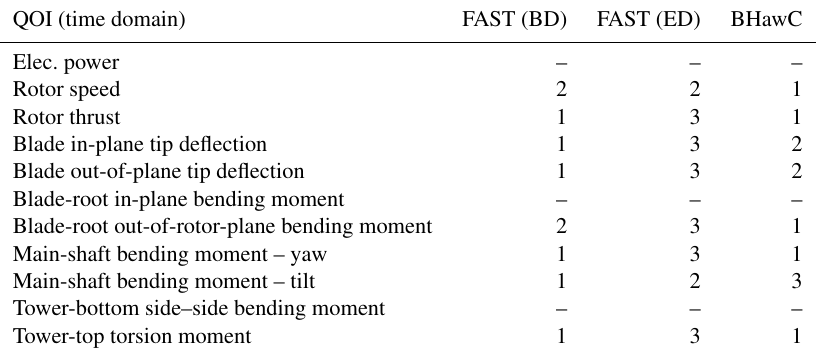
Table 2. The tools FAST (BD), FAST (ED), and BHawC ranked according to how well their results compare to the experimental measure- ments in the mean and standard deviation for each QOI. No value indicates that no discernible difference could be seen among the different tools for that QOI.